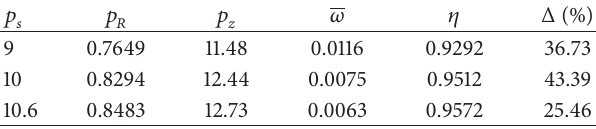
Table 1: Flow performance parameters in the different 𝑃 𝑟